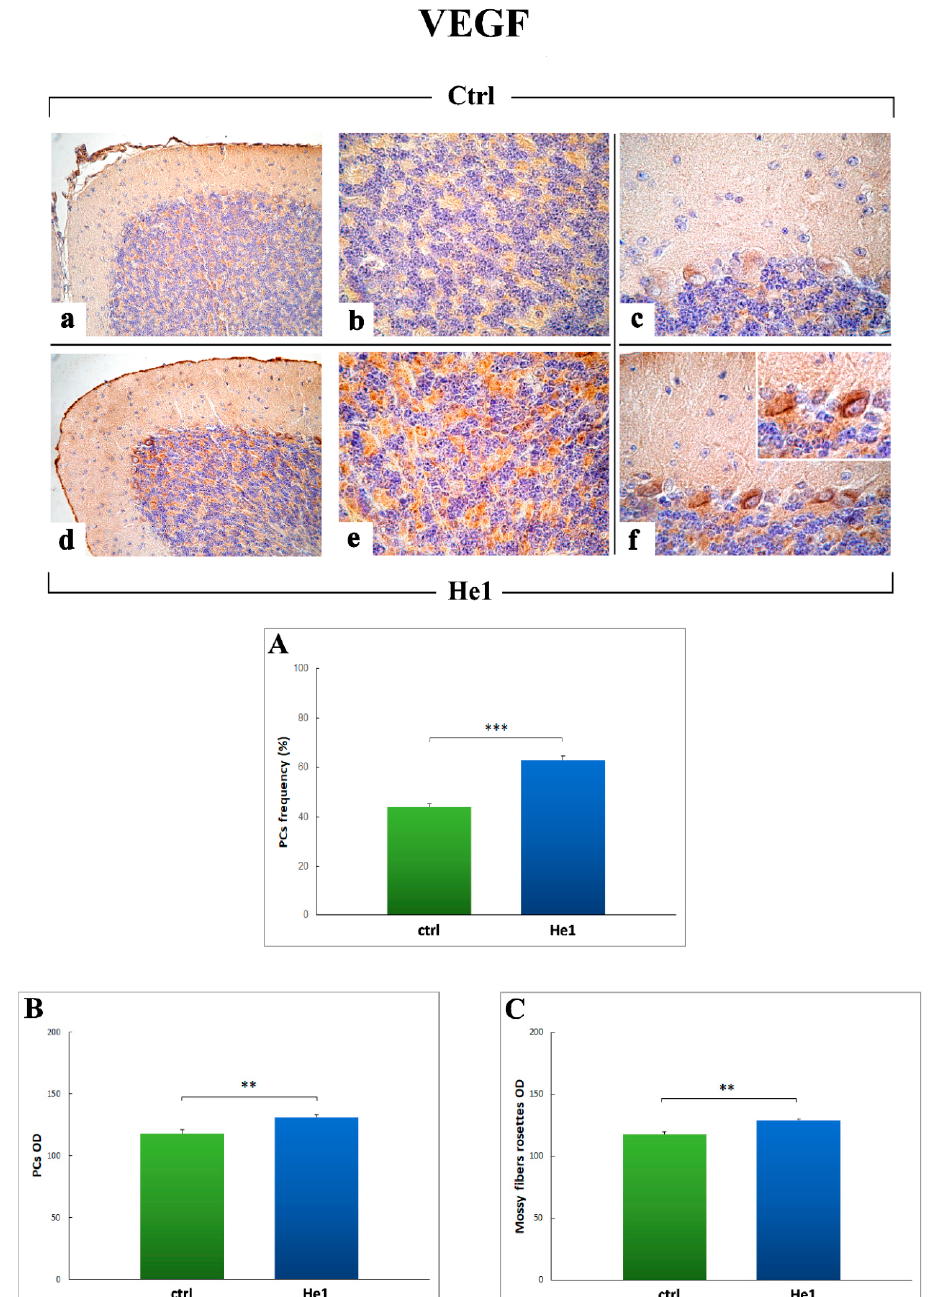
Figure 10. VEGF DAB-immunostaining reaction in untreated ( a – c ) and He1-treated mice ( d – f ). Light microscopy magnification: 40× ( a – f ); 100× ( insert in f ). Panels ( A – C ) Histograms showing the quantitative measurement of VEGF-immunoreactive cell frequency and OD for both Purkinje neurons and mossy fibers rosettes. p values calculated by unpaired Student’s t -test: ** p < 0.01, *** p < 0.001.